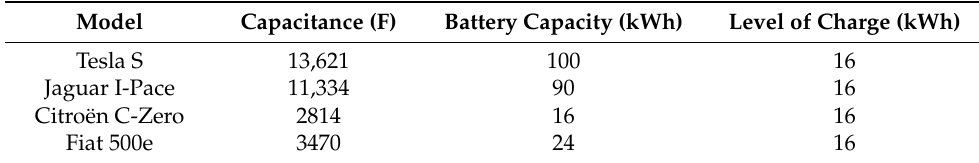
Figure 5. Battery terminal voltage ( a ) and current ( b ) of the EVs during charging for this second scenario. Considering specifically the four cars requesting the same amount of charge, it is relevant to look at their starting sequence (relevant data is shown in Table 6). Table 6. Car data for requests for the same amount of